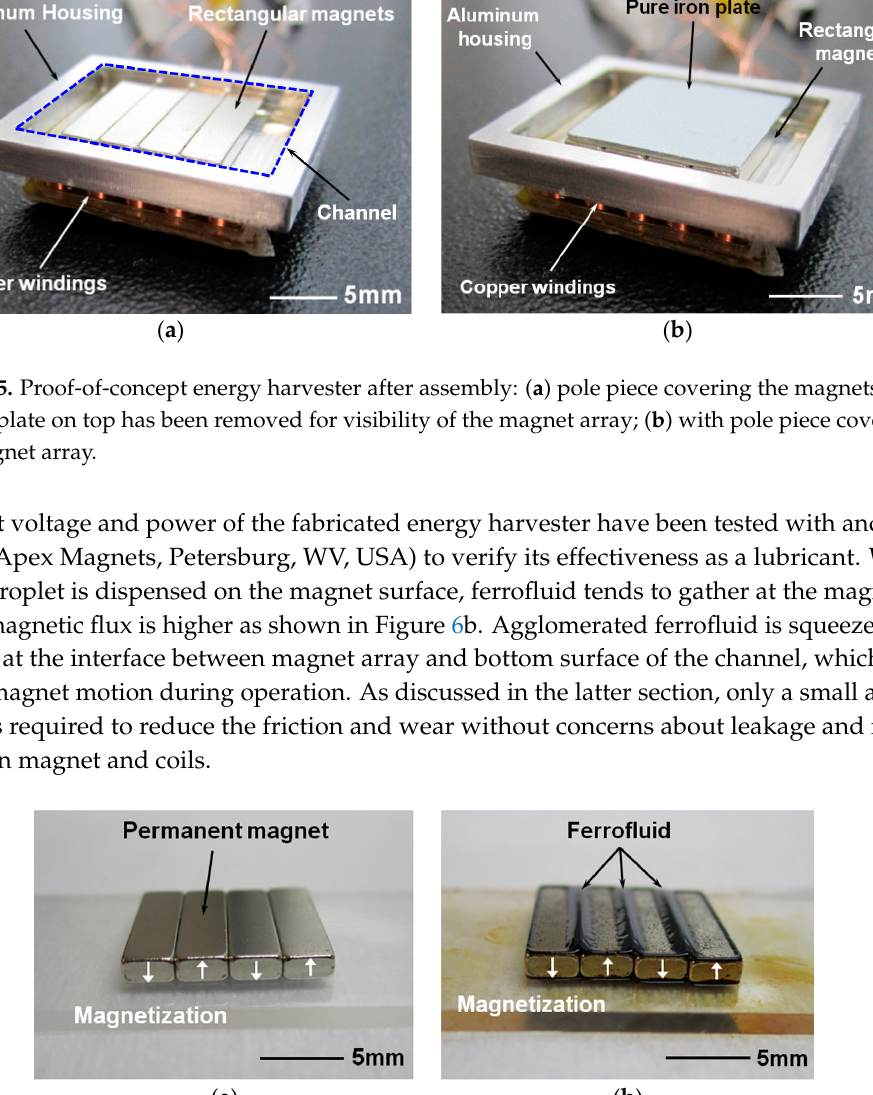
Figure 6. Magnet array: ( a ) in pristine condition; ( b ) after ferrofluid droplet dispense.